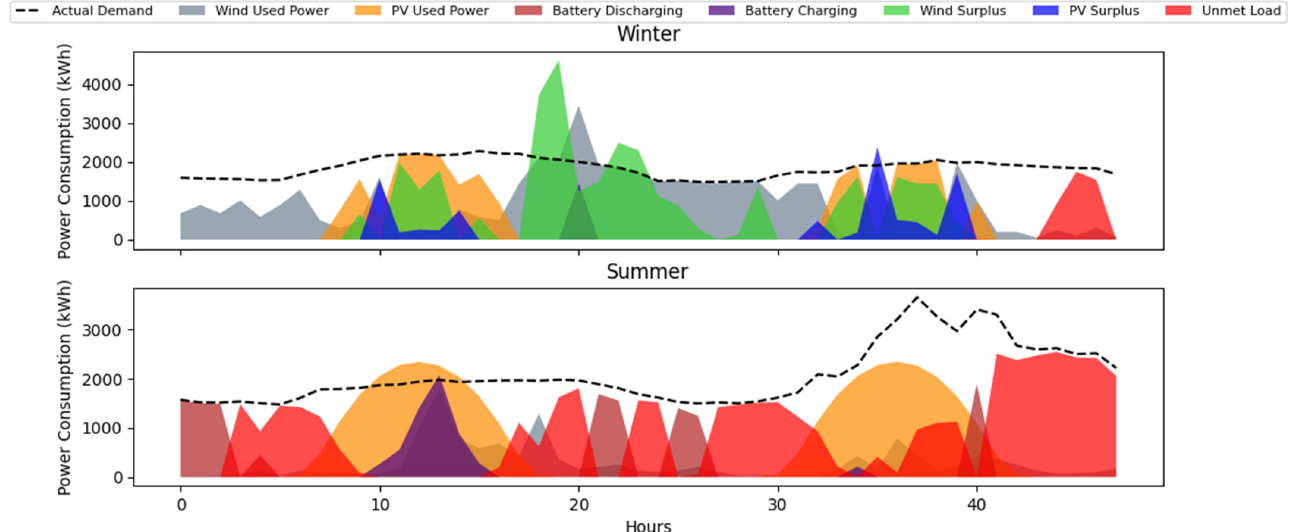
Figure 3. Optimal Schedule using actual load demand. Table 6. Comparison of the scheduling results for the actual, critical, and optimal loads.